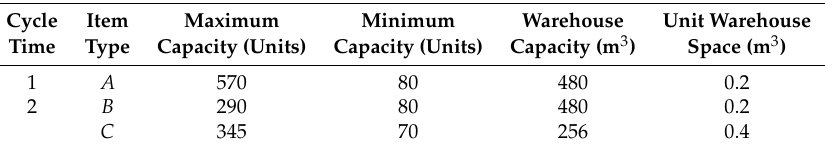
Table 6. Capacity limitation of manufacturing system and warehouse.